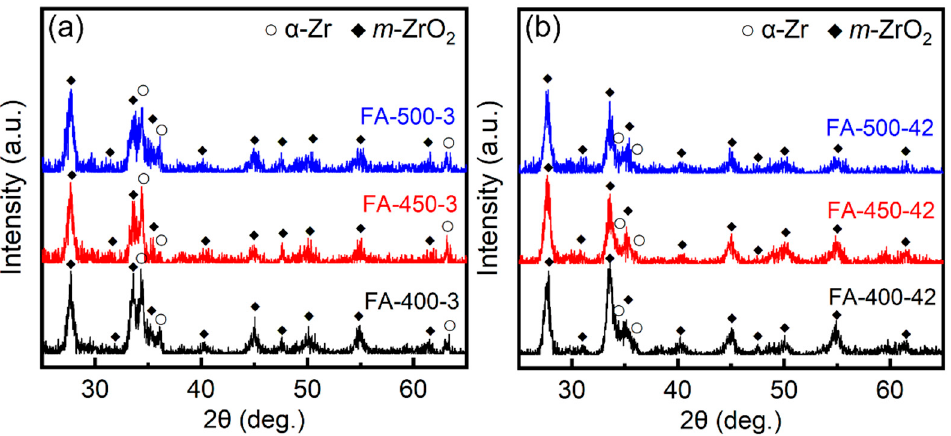
Figure 6. Grazing incidence X-ray diffraction (GIXRD) patterns for the FA-400, FA-450, and FA-500 immersed with ( a ) 3-day and ( b ) 42-day exposure.